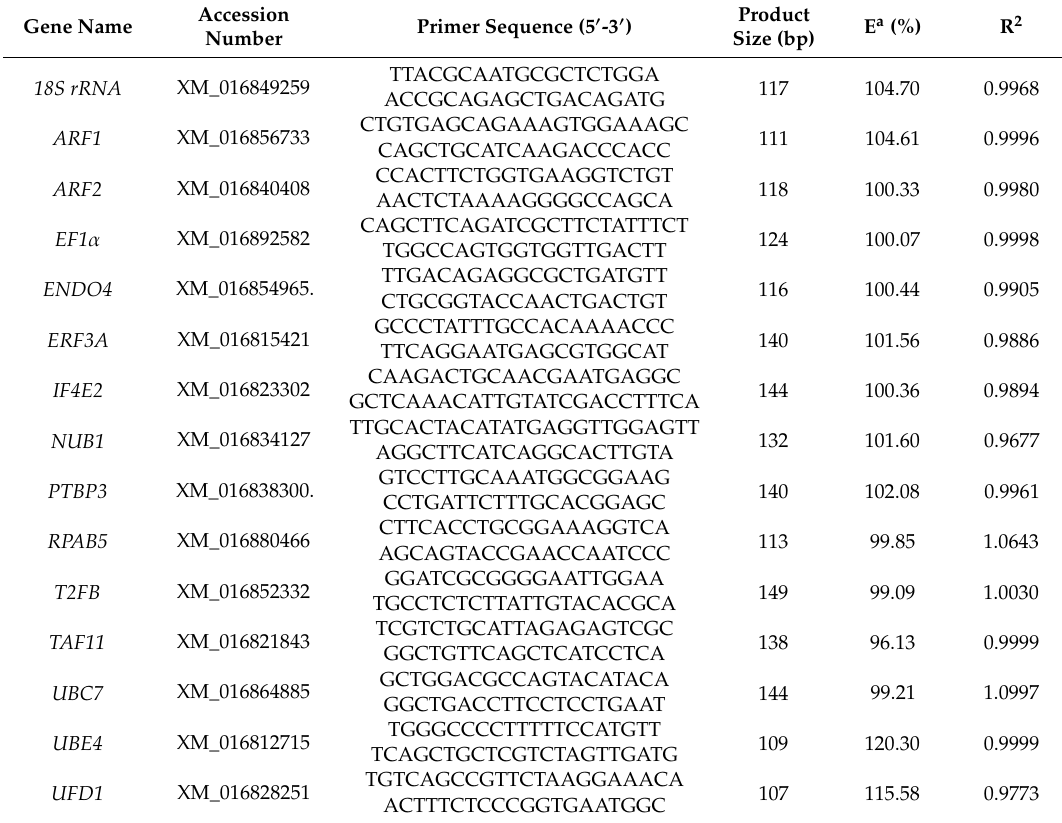
Table 1. Details of the 15 candidate reference genes, primer sequences, and amplification characteristics for RT-qPCR in G. hirsutum